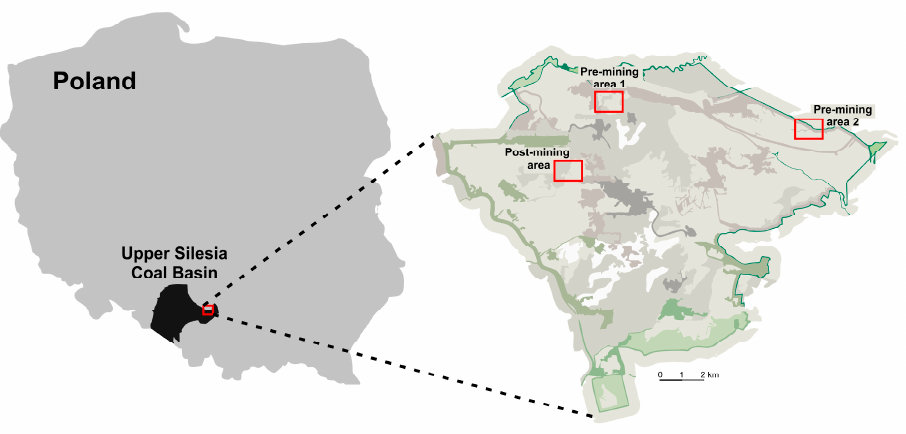
Figure 1. Location of the study area in Jaworzno town. Red rectangles—studied areas.